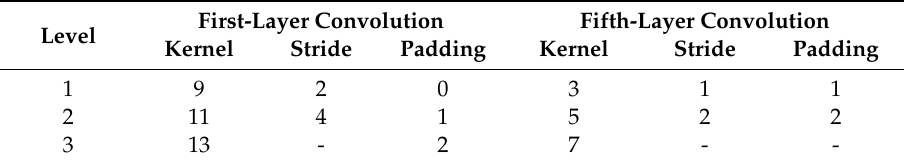
Table 6. The a ff ecting factors and levels of the two-input Table 6. The affecting factors and levels of the two-input CNN.